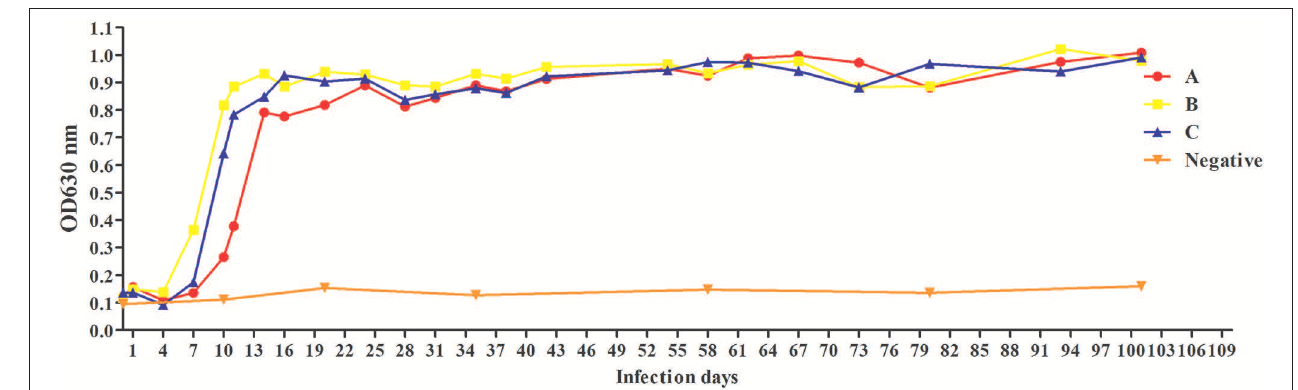
FIGURE 5 | Antibody response to rBgGPI47-WH in dogs experimentally infected with B. gibsoni . The dog B experimentally infected with B. gibsoni exhibited a significant antibody response to the BgGPI47-WH specific antigen on the sixth day post infection. The dogs A and C showed a significant antibody response to the BgGPI47-WH specific antigen on the eighth day post infection. The antibody response of all the three experimental dogs remained at high levels until 101 days after infection with B. gibsoni .